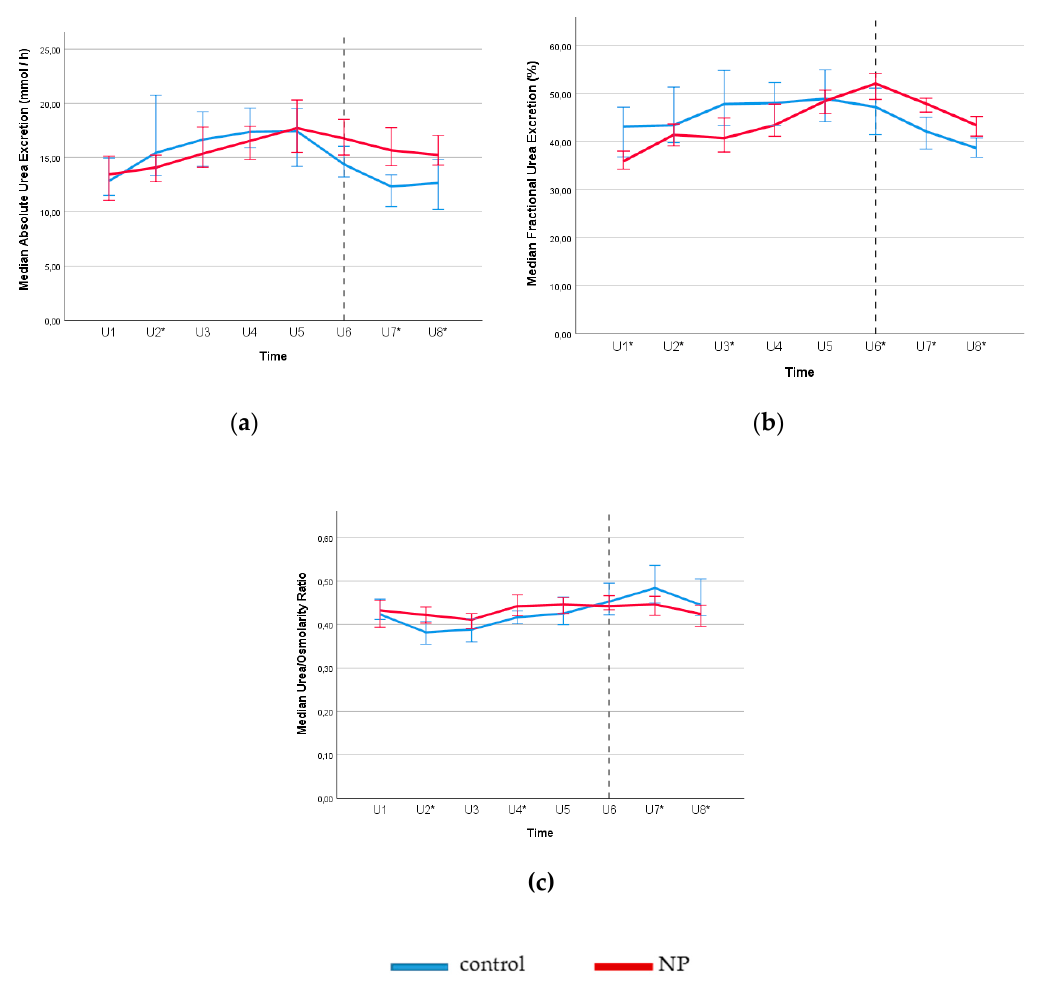
Figure 4. Circadian rhythms for absolute urea excretion ( a ), fractional urea excretion ( b ) and urea / osmolality ratio ( c ) for subjects with and without NP (control) according to eight urine samples collected over 24 h. Reference line separates the day and night time. Daytime urine samples were collected between 8–11 a.m. (U1), 11 a.m.–2 p.m. (U2), 2–5 p.m. (U3), 5–8 p.m. (U4), and 8–11 p.m. (U5). Nighttime urine samples were taken at 11 p.m.–2 a.m. (U6), 2–5 a.m. (U7), and 5–8 a.m. (U8). * p < 0.05 for NP versus the control group (Mann–Whitney U test). Error bars: 95% CI. Note: Subjects with NP shows higher urea excretion during the night time compared to the controls, which shows a blunted circadian rhythm in renal handling of urea in osmotic diuresis.